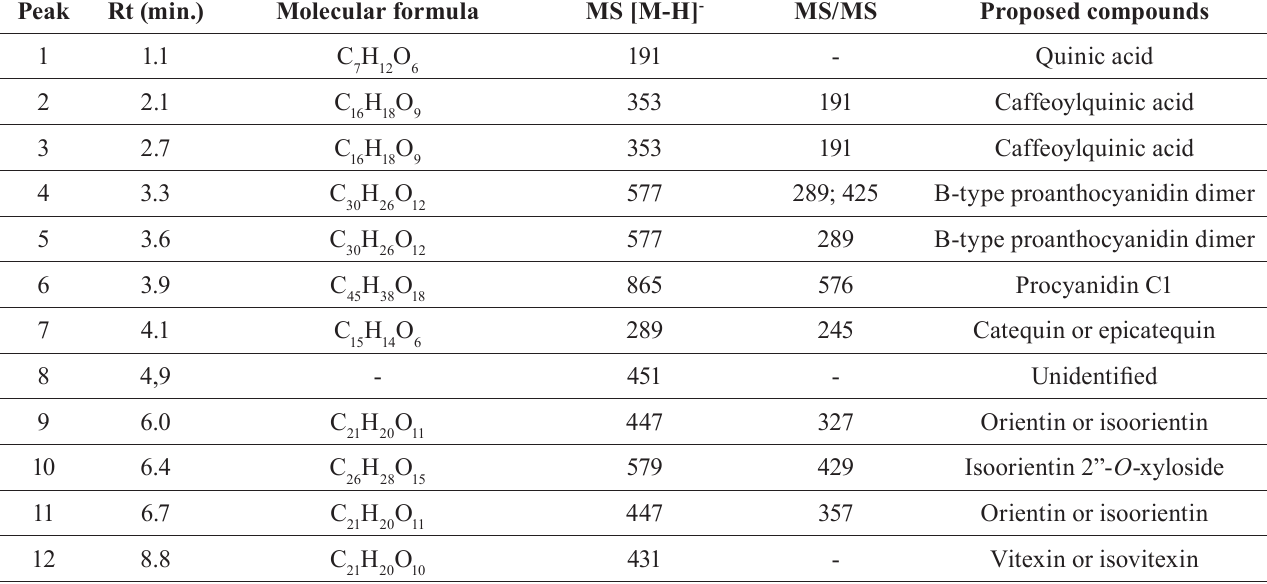
TABLE II - UHPLC-MS analysis of extracts CP01 and CP02 of Cecropia pachystachya Peak Rt